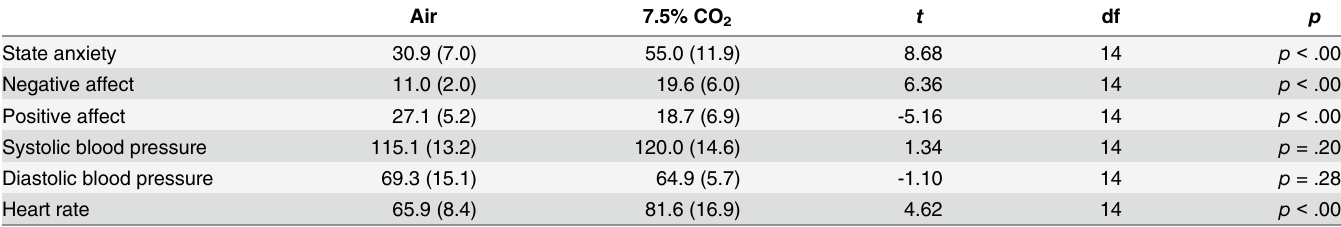
Table 5. Mean ( ± SD) for anxiety, mood, blood pressure and heart rate measures following inhalations of 7.5% CO 2 and normal air.